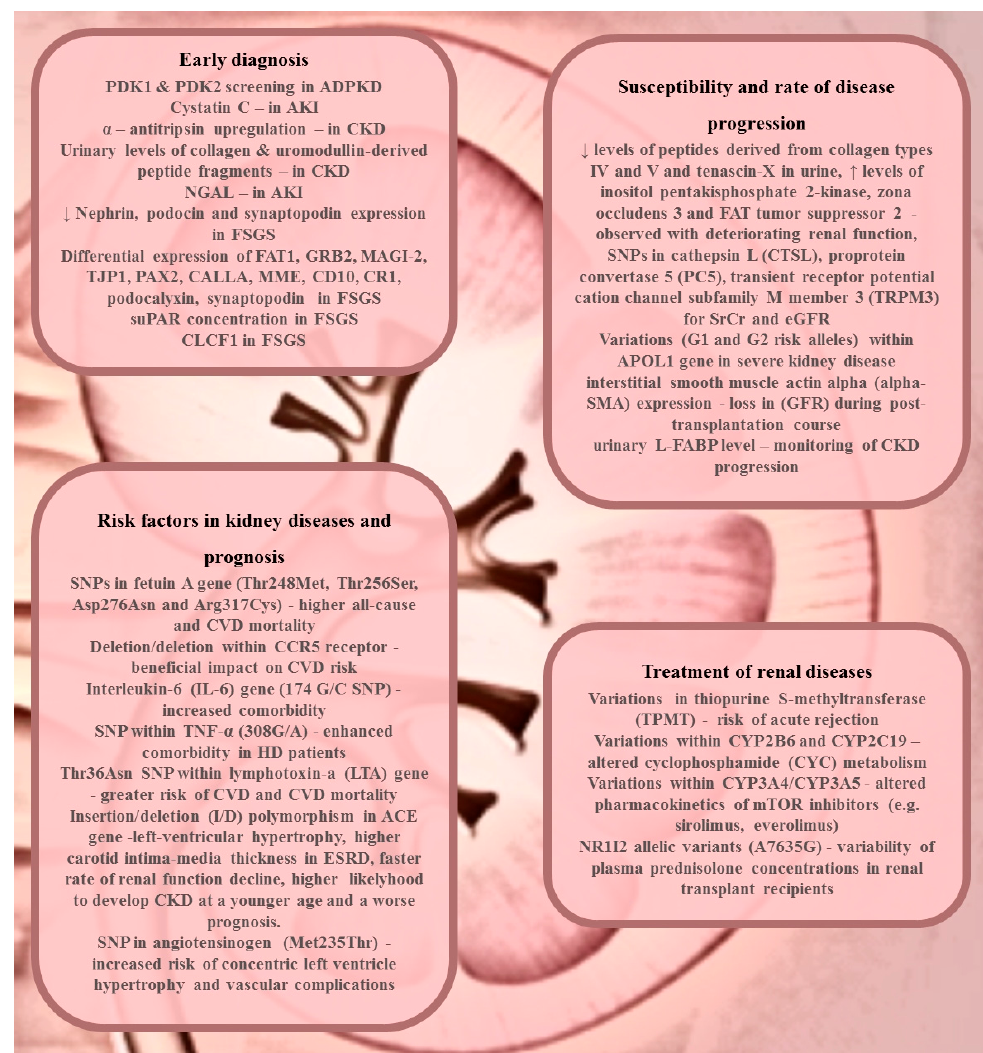
Figure 1. CKD-related biomarkers in personalized medicine—summary